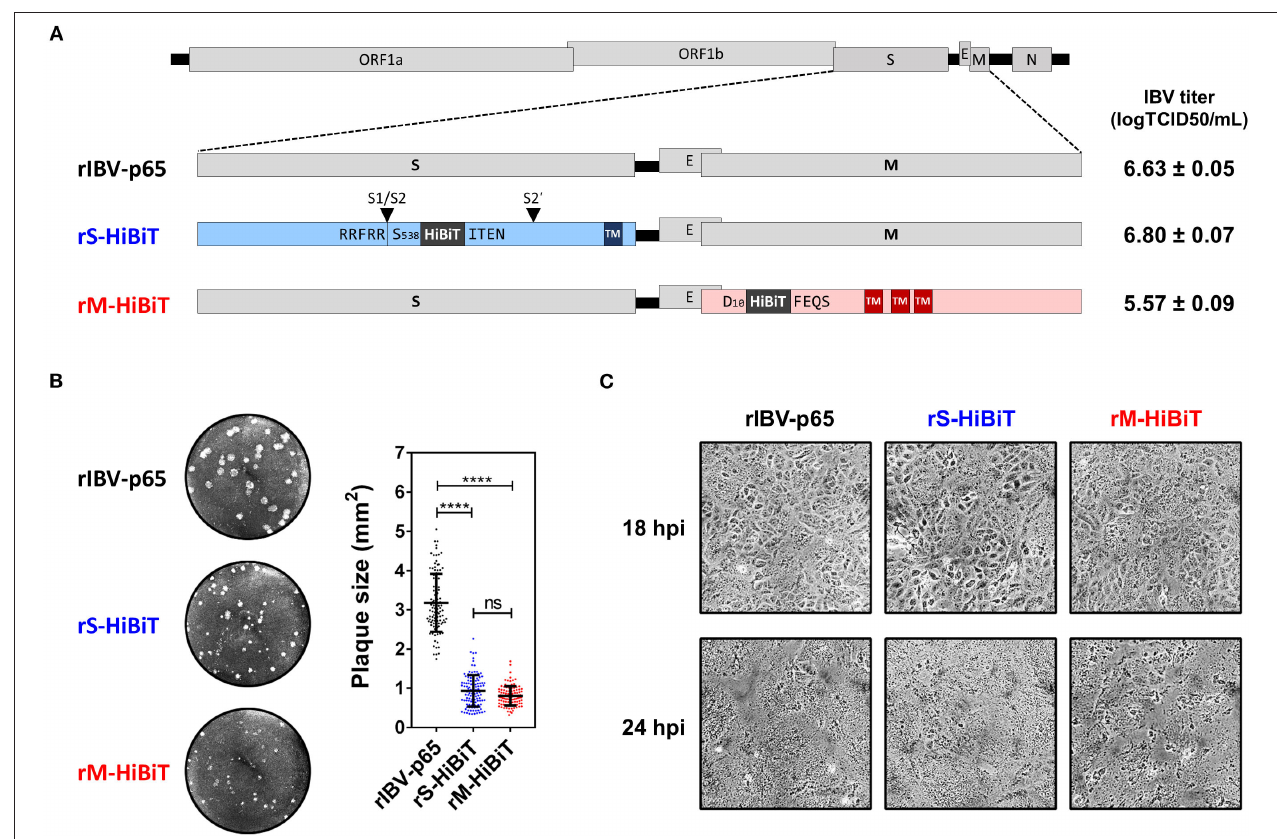
FIGURE 1 | Construction and characterization of HiBiT-tagged rIBVs. (A) Schematic diagram showing the genomic structures of rIBVs used in this study. The HiBiT tag was inserted immediately after S538 and D10 in rS-HiBiT and rM-HiBiT, respectively. S1/S2 and S2 ′ represent the proteolytic cleavage sites in the S protein. Titers of the IBV stocks were shown in the unit of log TCID50 per ml. TM, transmembrane domain. (B) Plaque morphologies and plaque areas of the rIBVs. Representative images of the plaque morphologies of the above three rIBVs were shown. The areas of at least 100 plaques were determined and plotted for each rIBV. The experiment was repeated three times with similar results, and the result of one representative experiment is shown. **** p < 0.0001; ns, non-significant. (C) Cytopathic effect of Vero cells infected with the rIBVs. Vero cells were infected with rIBV-p65, rS-HiBiT, or rM-HiBiT at a multiplicity of infection (MOI) of ∼ 2. Phase images were captured at 18 and 24h post-infection (hpi). The experiment was repeated three times with similar results, and the result of one representative experiment is